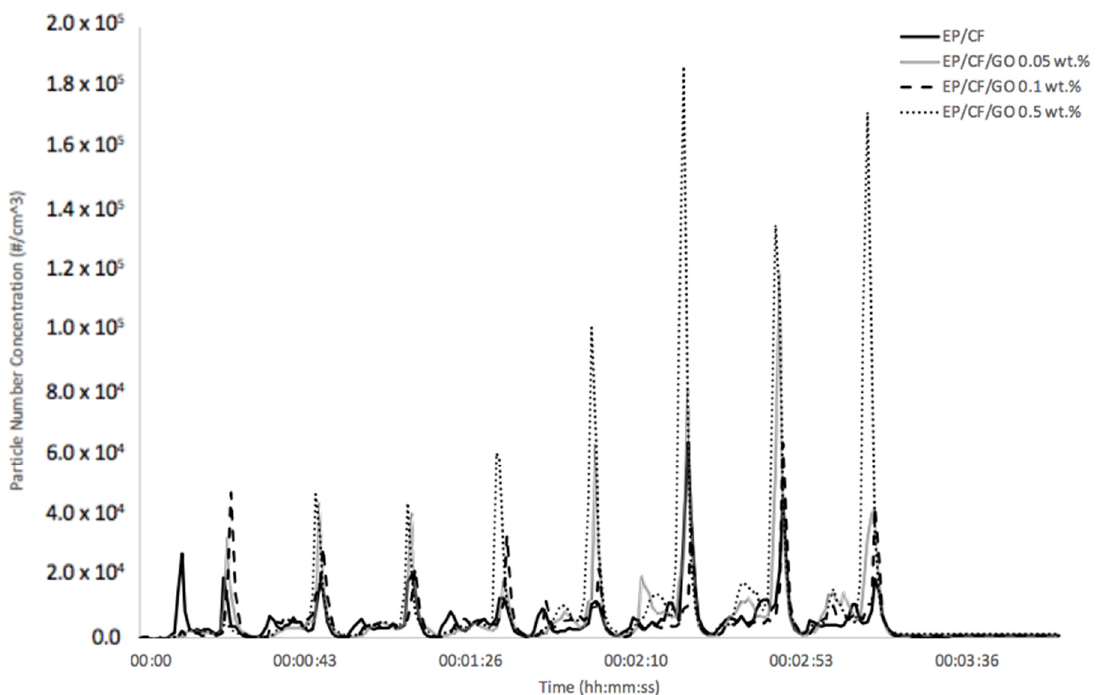
Figure 3. Particle number concentration averages of nanoparticles introduced from EP / CF-based samples reinforced with GO and measured using condensation particle counter (CPC) ( n = 3 for each average).